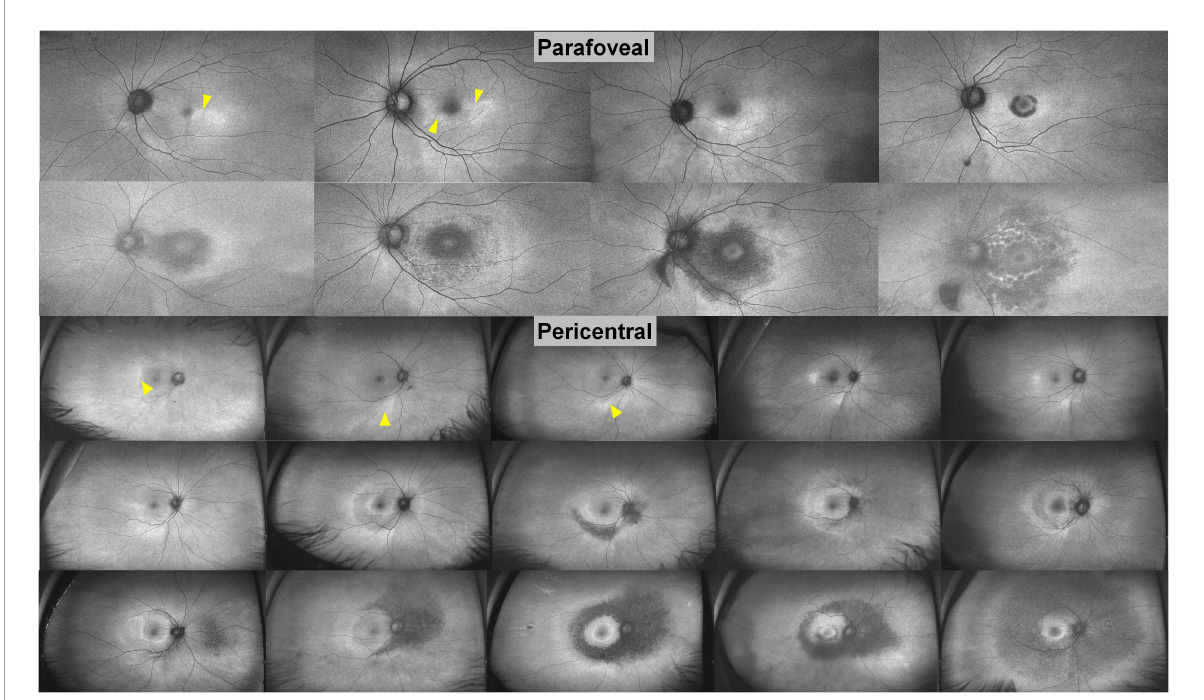
FIGURE5 Ultra-widefield fundus autofluorescence images in patients with parafoveal and pericentral hydroxychloroquine retinopathy, placed in order of severity based on the extent of hyper- and hypo-autofluorescence. From a temporal or inferior patchy hyperautofluorescence (arrowheads) to extensive hypoautofluorescence, the extent of retinal damage increases significantly [Modified from Ahn et al.